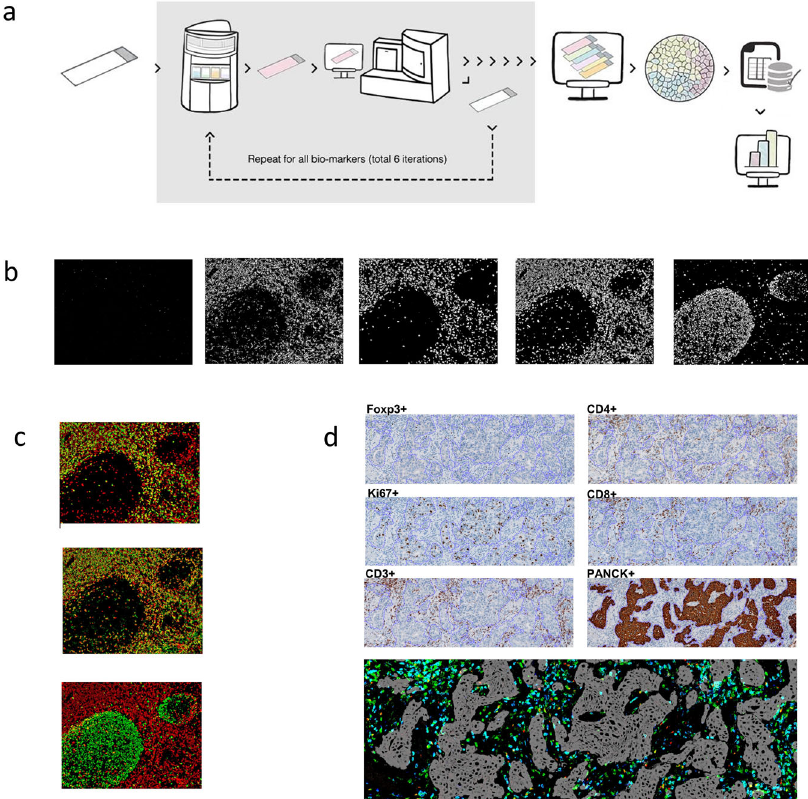
Fig. 1 Multiplexed imaging assay. a Next-generation immunohistochemistry (NGI) work fl ow. An FFPE tissue section is stained, scanned and destained six times. All the scanned images are aligned, image analysis is done to obtain the data and after doing all the quality check controls, the data are analysed to obtain the fi nal results. b Representative colour deconvoluted images of different biomarkers in the tonsil. From left to right Foxp3 + , CD3 + , CD8 + , CD4 + and Ki67 + . Images at 6×. c Colour overlays of different biomarkers in the tonsil (CD3 + in red, CD8 + , CD4 + and Ki67 + in green from top to bottom). Images at 6×. d A representative example of all the stainings (Foxp3, CD4, KI67, CD8, CD3 and cytokeratin) in breast cancer samples and virtual image reconstruction of some of them by assigning virtual colours to the deconvoluted images. Foxp3 + in red, CD8 + in blue, CD3 + in green and cytokeratin in grey. The fi ne purple line in each image marks the tumour borders. Images at